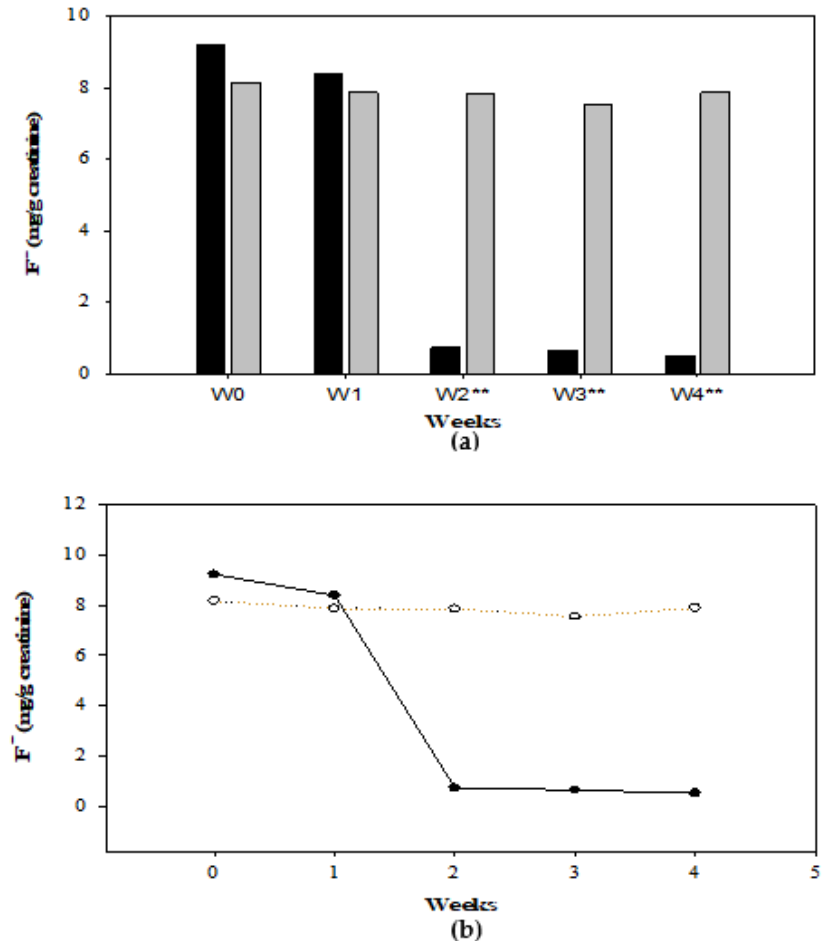
Figure 3. ( a ) Comparison of the F − concentration (median) before, during, and after 4 weeks of supplementation between the treated group (G1 − Black bars) and the untreated group (G2 − Gray Bars) (W0: baseline; W1: week 1; W2: week 2; W3: week 3; W4: week 4). ** Statistically significant difference between groups according to the Mann–Whitney U test with p < 0.001. ( b ) Comparison of the concentrations of F − (median) in the treated (Black line) and untreated groups (Dotted line) by week of treatment. Friedman and Wilcoxon tests were performed to determine differences between weeks for G1 and G2. The interquartile range (IQR) was included for W0 (G1: 2.43; G2: 2.93), W1 (G1: 3.52; G2: 2.50), W2 (G1: 0.44; G2: 2.40), W3 (G1: 0.70; G2: 1.60), and W4 (G1: 0.34; G2: